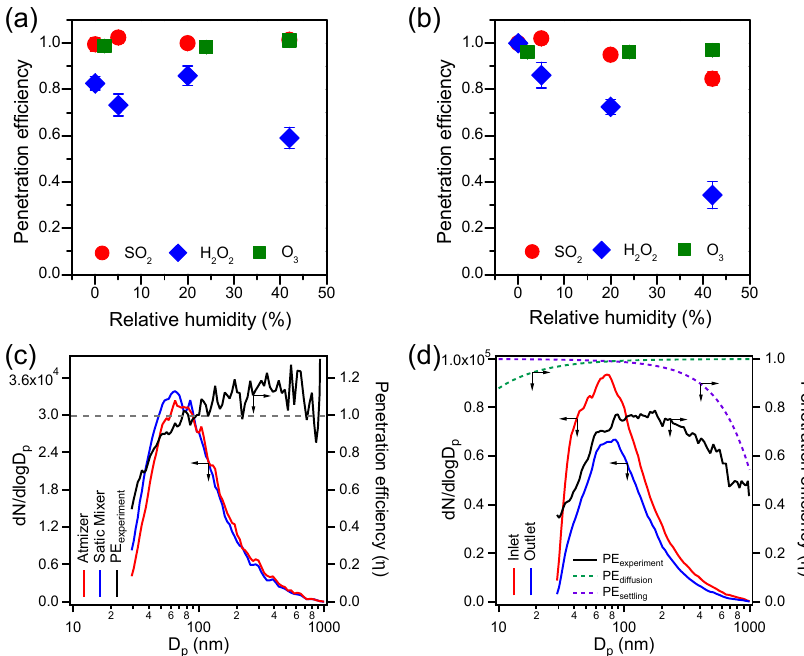
Figure 9. Penetration efficiency ( η ) of gases and particles in the static mixer and the flow tube. (a) Relative-humidity-dependent η of SO 2 , H 2 O 2 and O 3 in the static mixer. (b) Relative-humidity-dependent η of SO 2 , H 2 O 2 and O 3 in the flow tube. Error bar indicates the measured uncertainty. (c) Measured ammonium sulfate particle size distributions before and after the static mixer, as well as the η derived from these measurements. The gray dashed line indicates η = 1, i.e., no particle loss. (d) Measured ammonium sulfate particle size distributions at the inlet and outlet of the flow tube, as well as the η derived from these measurements. The calculated η with respect to particle diffusion loss (Eq. 4) and gravitational settling (Eq. F6) are indicated by the dashed lines.